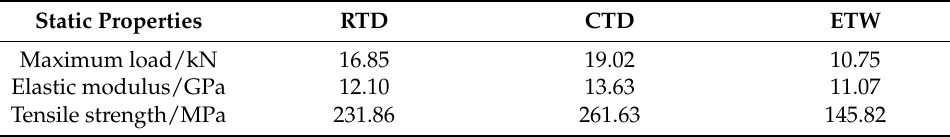
Table 5. Average tensile properties in three environments.